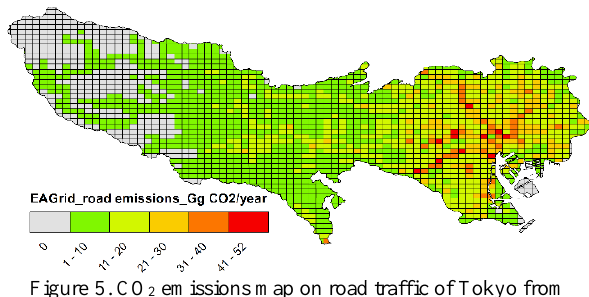
Figure 3. Total CO 2 emissions from road traffic in each sub-city of Tokyo in 2015, unit: Gg CO 2 yr -1